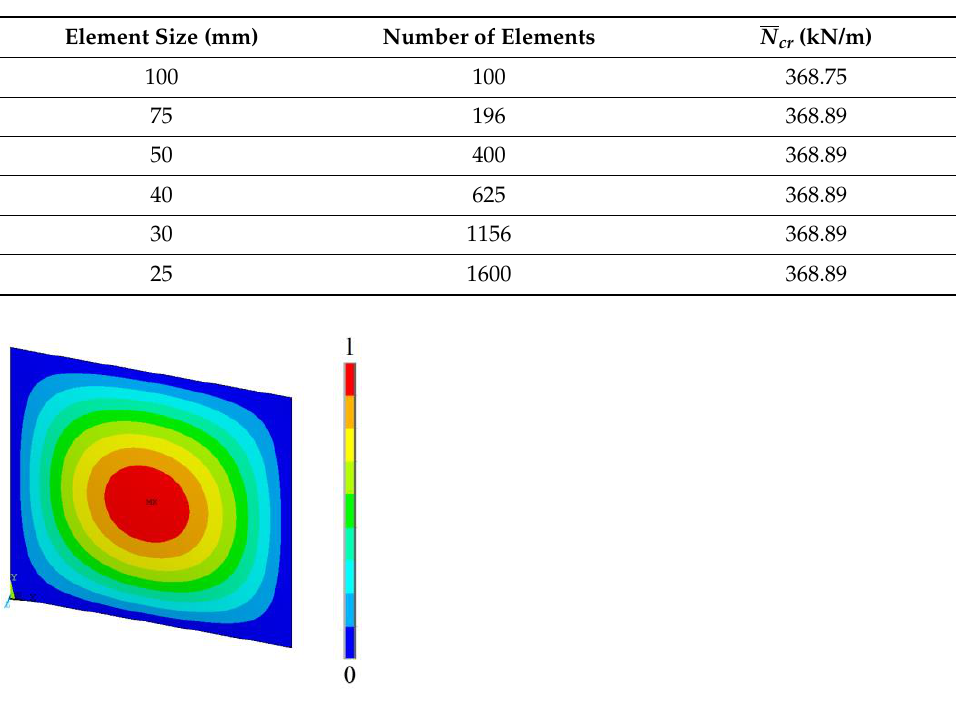
Figure 4. Simply supported square plate with centered square hole.